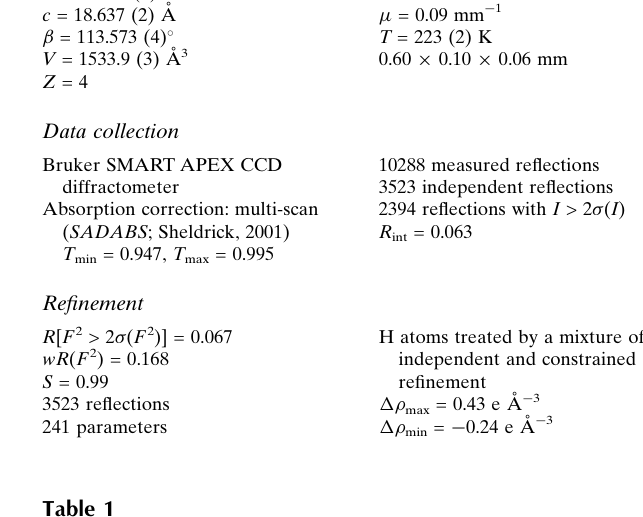
Hydrogen-bond geometry (A˚ , (cid:2)